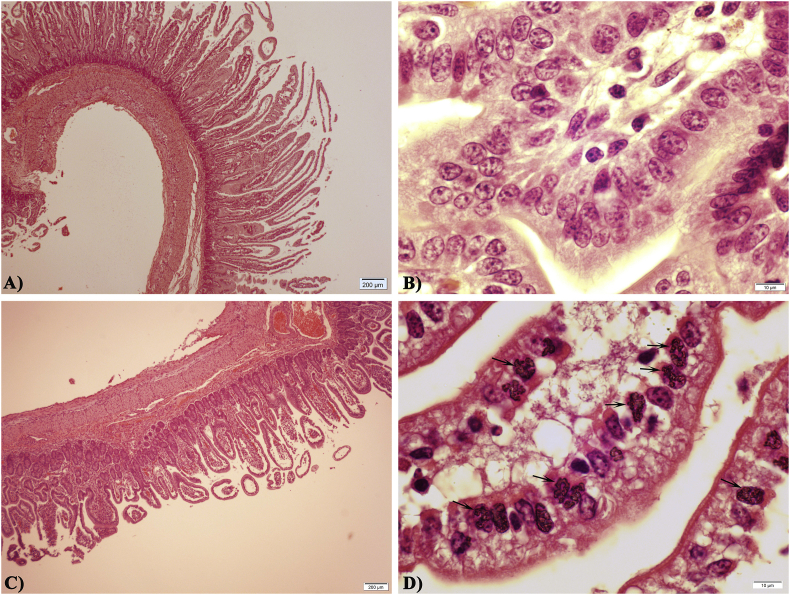
Histological sections of jejunum in C. suis infected 9-days-old piglets from group Wien-BKI (A–B) and Wien-Ctrl (C–D); Infection with C. suis resulted in stunted and atrophied villi (C) with numerous asexual endogenous stage (arrows, D); (H&E stain).